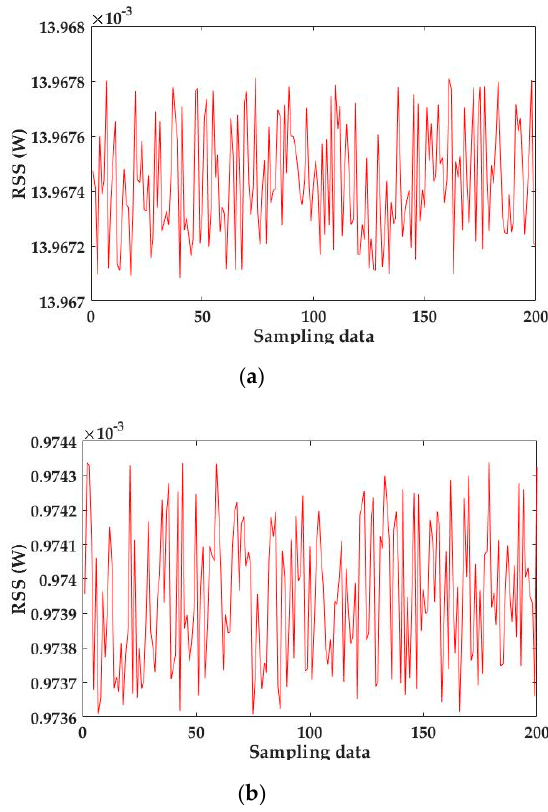
Figure 7. Sampling data by: ( a ) LOS signals and ( b ) diffuse signals.